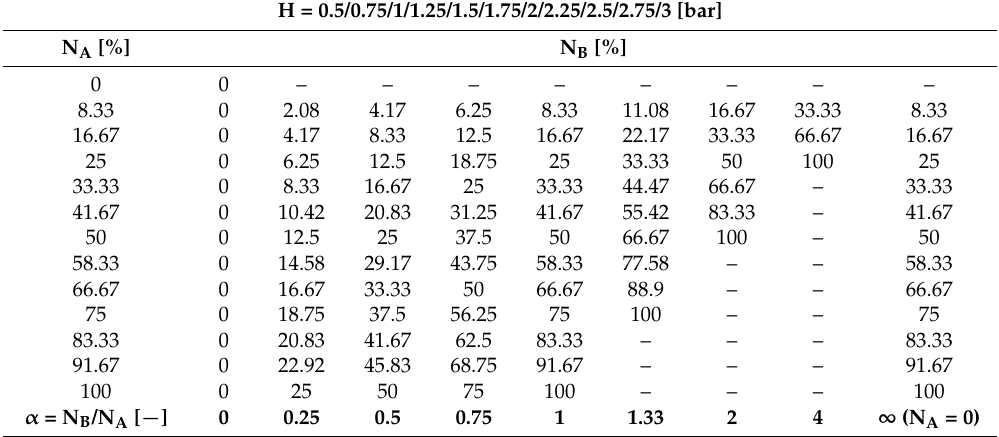
Table 2. Combinations of rotational speeds of the microturbine runners for point-by-point performance measurements.